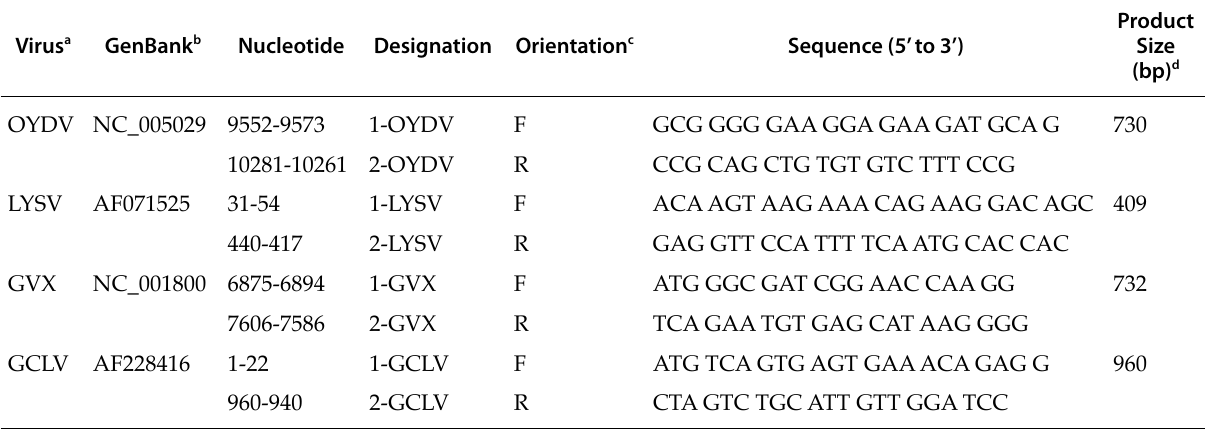
a OYDV, Onion yellow dwarf virus ; LYSV, Leek yellow stripe virus ; GVX, Garlic virus X, and GCLV, Garlic common latent virus . b Sequence accession numbers. c F, Forward; R,